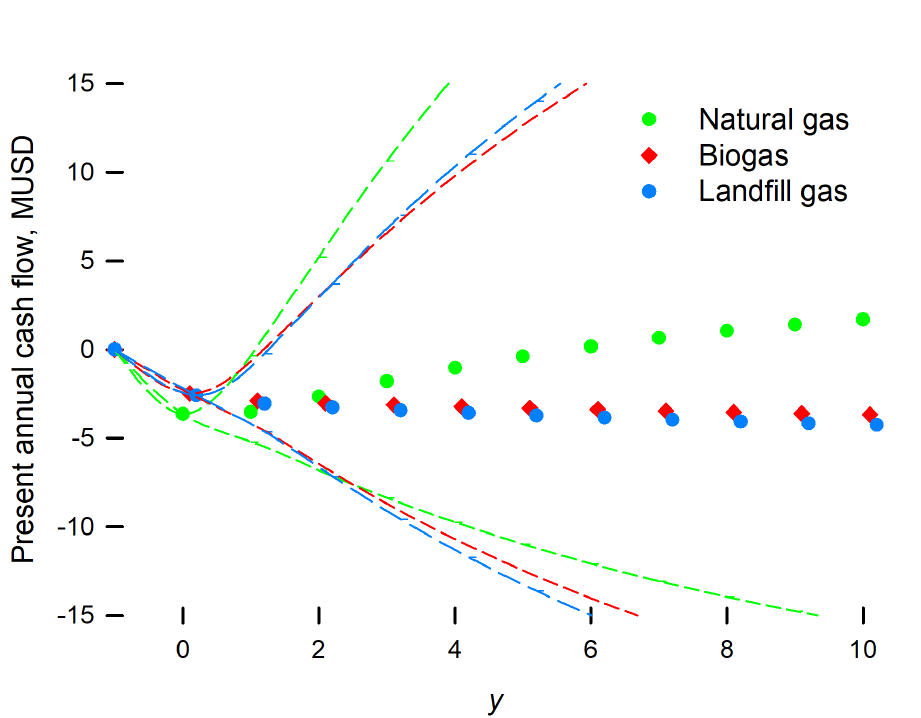
Figure 6. Present annual cash flow of the MRU for the three feedstocks studied. Lines represent the best possible scenario (cost of feedstock discounted by the carbon tax ( − 50USDt − 1 gCO 2eq ) and an FT fuel price of 0.2USDkg − 1 ); and the worst possible scenario (cost of feedstock of 0.23USDkg − 1 and an FT fuel price of 0.4USDkg − 1 ). Symbols represent the base-case scenario (cost of feedstock of 0USDkg − 1 and an FT fuel price of 0.3USDkg − 1